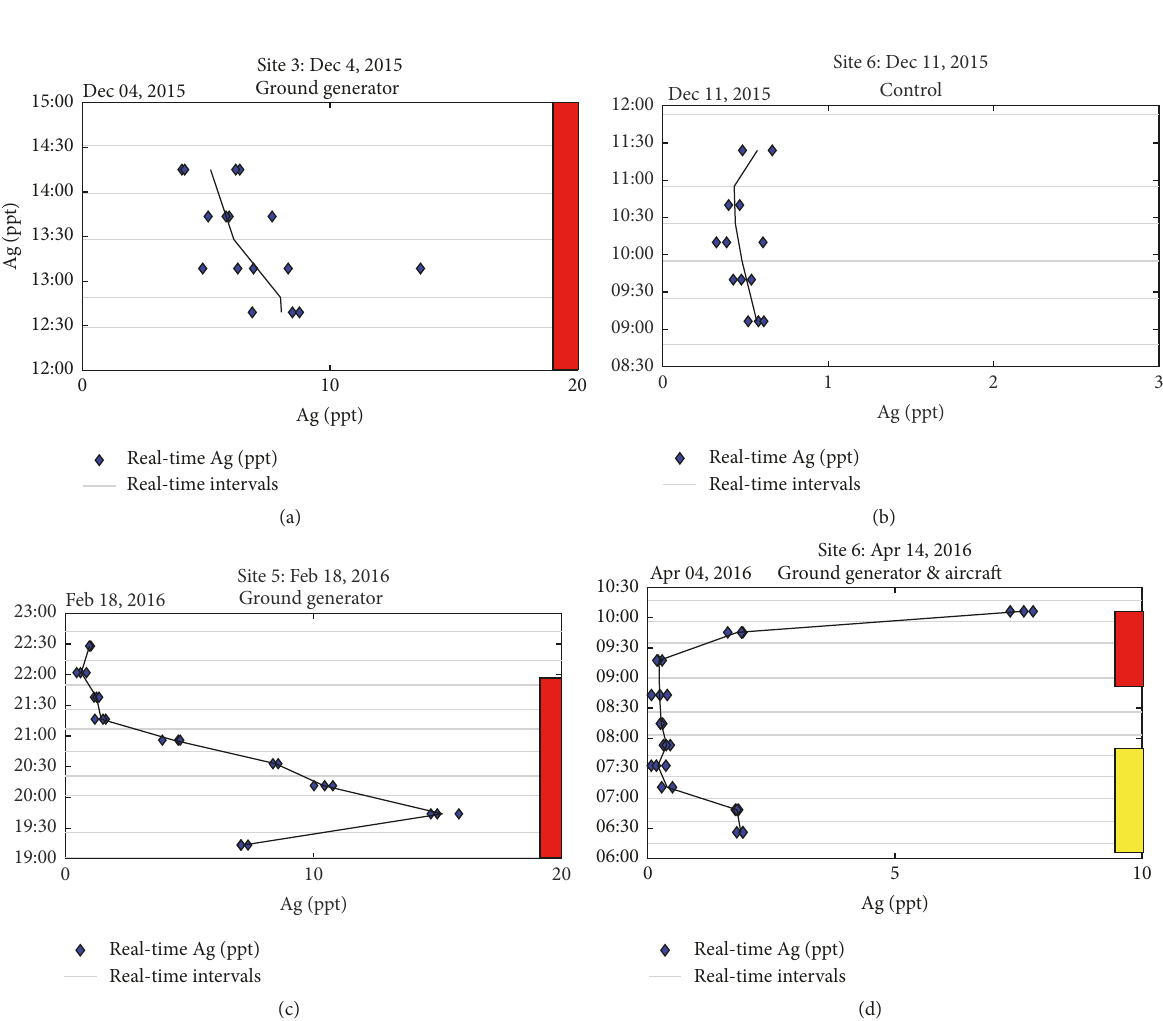
Figure 4: All 4 real-time sampling results from the season. Red bars denote times of ground generator seeding. Yellow bars denote aircraft seeding. Light grey lines delineate sampling intervals. Blue diamonds denote silver concentrations of samples collected during the time delineated between the grey